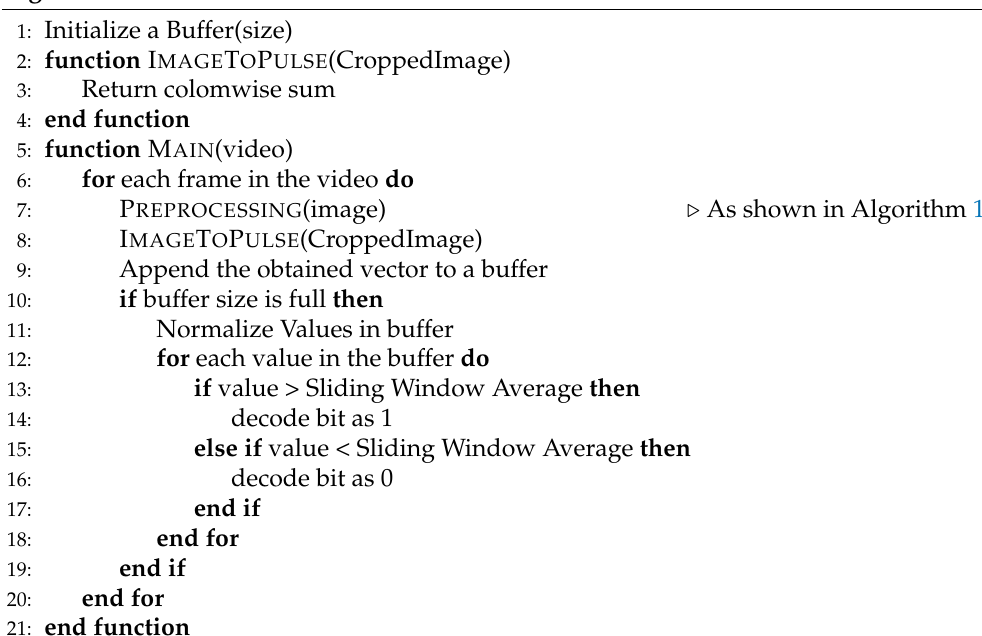
Algorithm 3 OOK Demodulation for OCC-LiFi